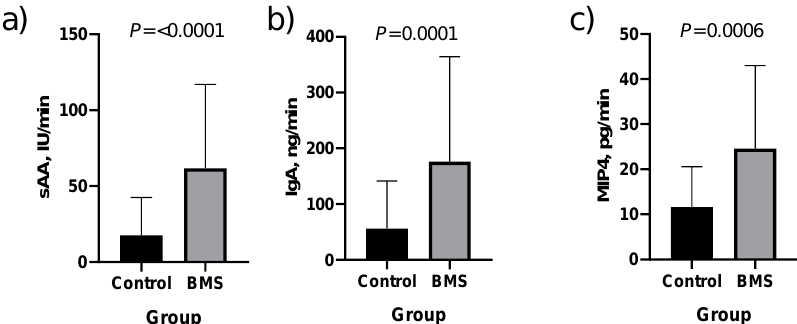
Figure 2. Salivary alpha-amylase (sAA; ( a )), immunoglobulin A (IgA; ( b )) and macrophage inflammatory